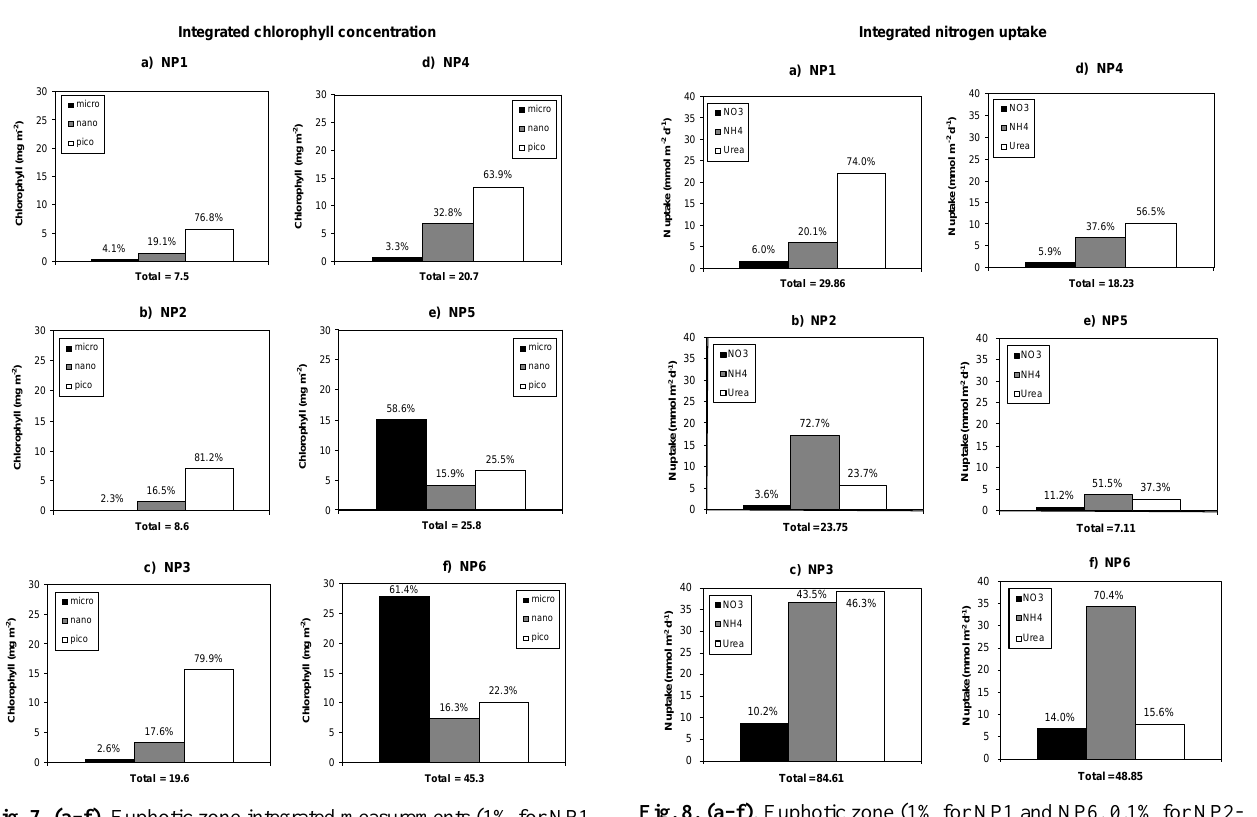
Fig. 7. (a–f) . Euphotic zone integrated measurements (1% for NP1 and 0.1% for NP2–NP6) of size-fractionated chlorophyll (mgm − 2 ) represented as a percentage of total integrated chlorophyll for the six productivity stations on the Southbound Transect. Numbers at the top of each bar represent the percent contribution of each size fraction, with the total integrated chlorophyll concentration (micro + nano + pico) at the bottom of each figure.